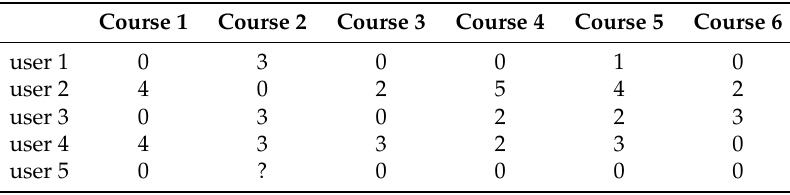
Table 3. Example of a user-to-course degree